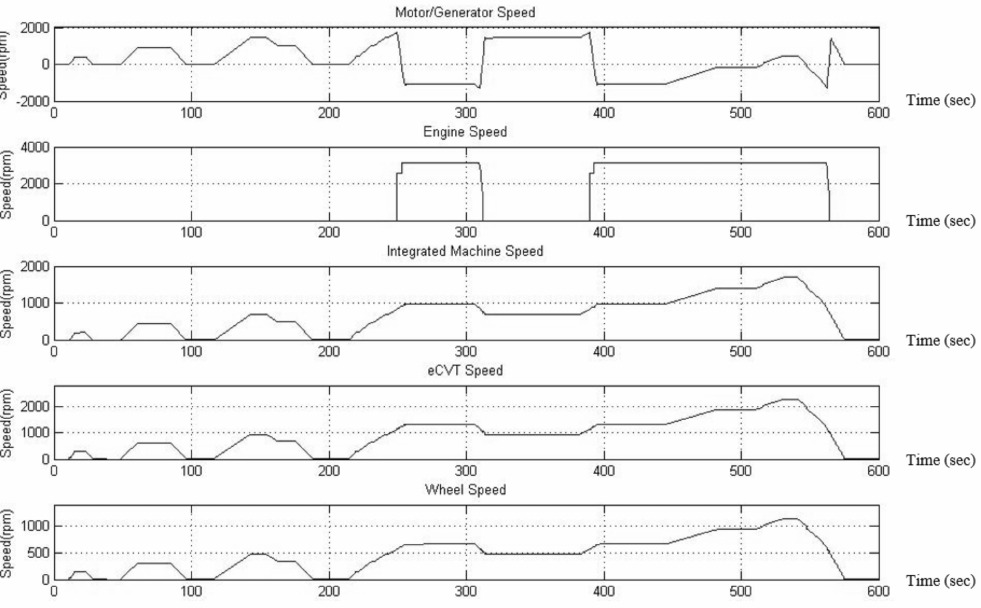
Figure 8. Output speed diagram of various components in the NEDC2000 driving